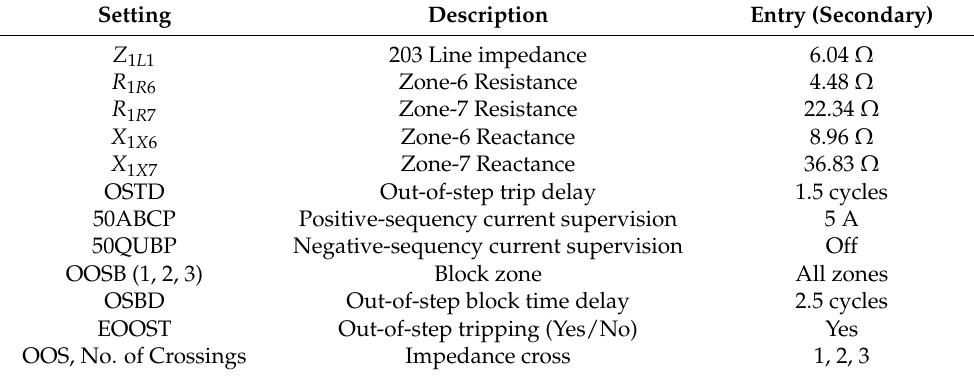
Table 3. Line-203 settings of OOS